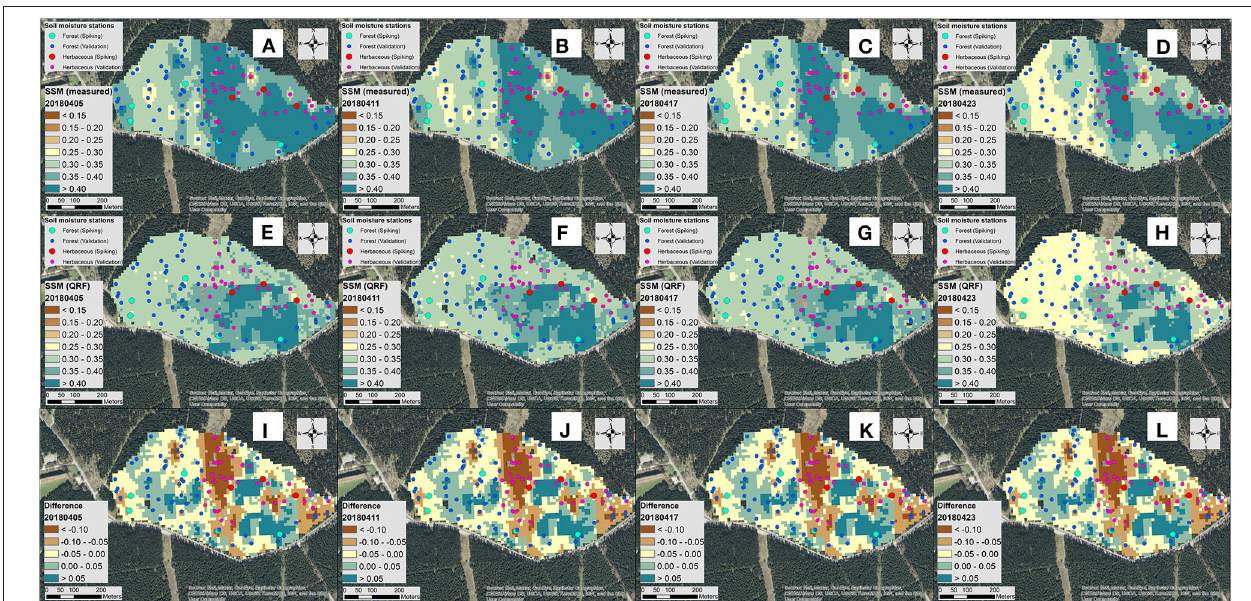
FIGURE 8 | Measured (interpolated soil moisture network measurements using inverse distance weighing, A–D ) vs. predicted surface soil moisture (SSM, m 3 m − 3 ) from the quantile random forest (QRF) model during a drying event from 2018/04/05 to 2018/04/23 across the field-scale TERENO-Wüstebach soil moisture network (E–H) . The QRF model was established with local training datasets (spiking) and Sentinel-1 aggregated at 10m. The differences were calculated by subtracting QRD model estimates pixel-wise with measured SSM values (I–L) .